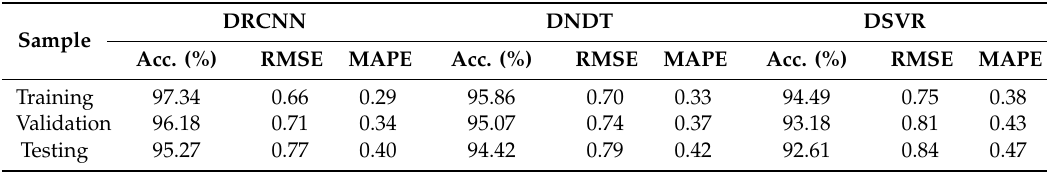
Table 3. Results of accuracy evaluation: classification